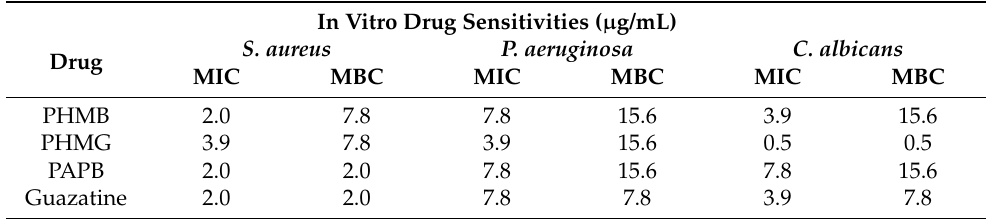
Table 2. The Minimum Inhibitory Concentration (MIC) and Minimum Biocidal Concentration (MBC) of PHMB, PHMG, PAPB and guazatine against P. aeruginosa , S. aureus and C. albicans . In Vitro Drug Sensitivities ( µ g/mL) S. aureus P. aeruginosa C. albicans Drug MIC MBC MIC MBC